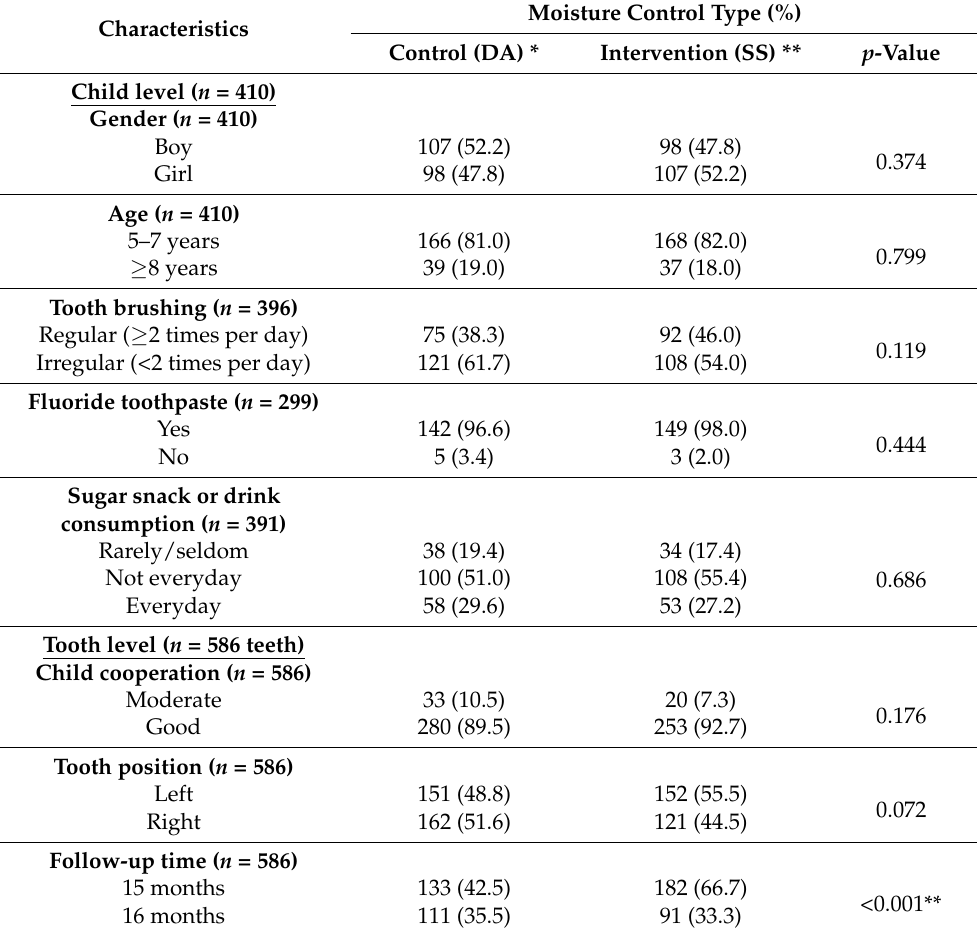
Table 2. Baseline characteristics of follow-up cases (410 children 586 teeth) at 15–18 months by